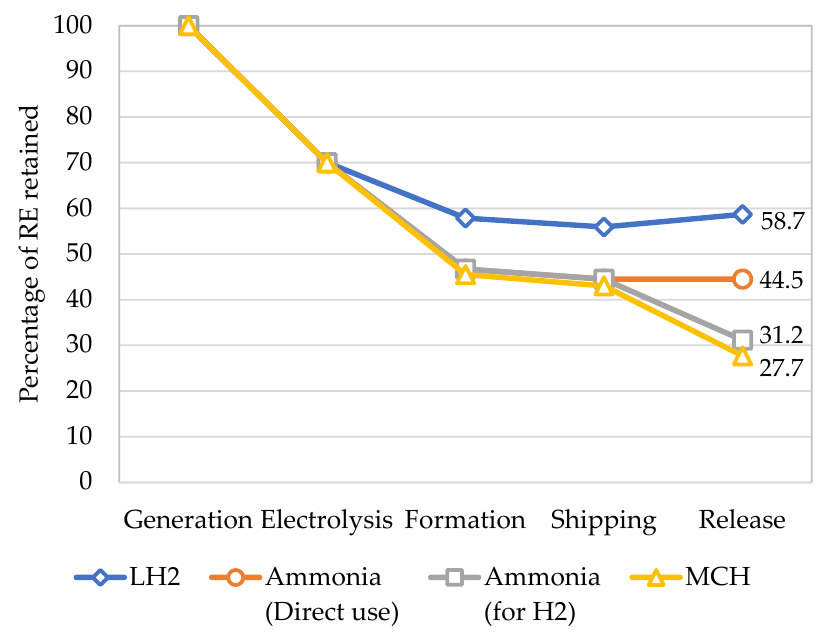
Figure 4. Amount of RE energy retained at stages along the supply chain from Bluff to Yokohama (data from Tables